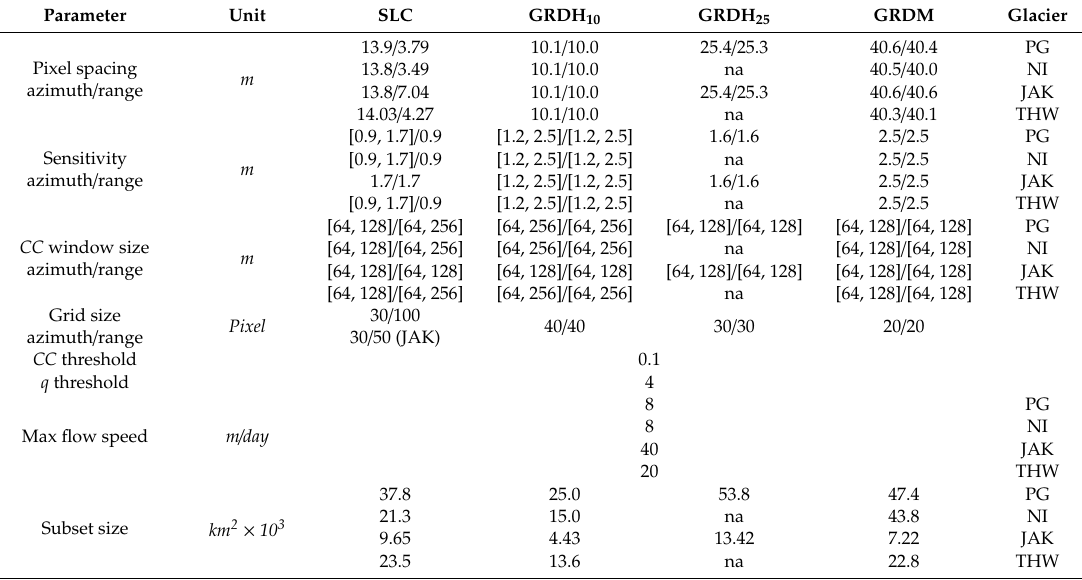
Table 1. OT algorithm parameters for the di ff erent product classes and test